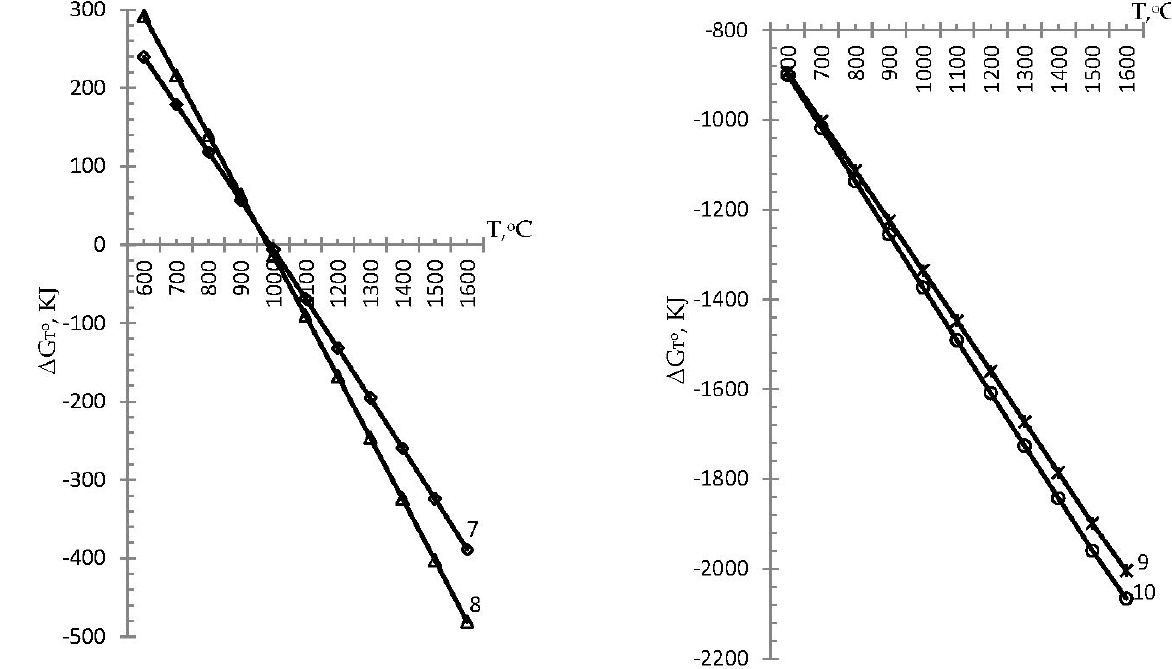
Figure 2. Influence of temperature on the Gibbs energy of the possibility of reactions in the presence of zinc metasilicate with the formation of clinker minerals and the simultaneous stripping of zinc.